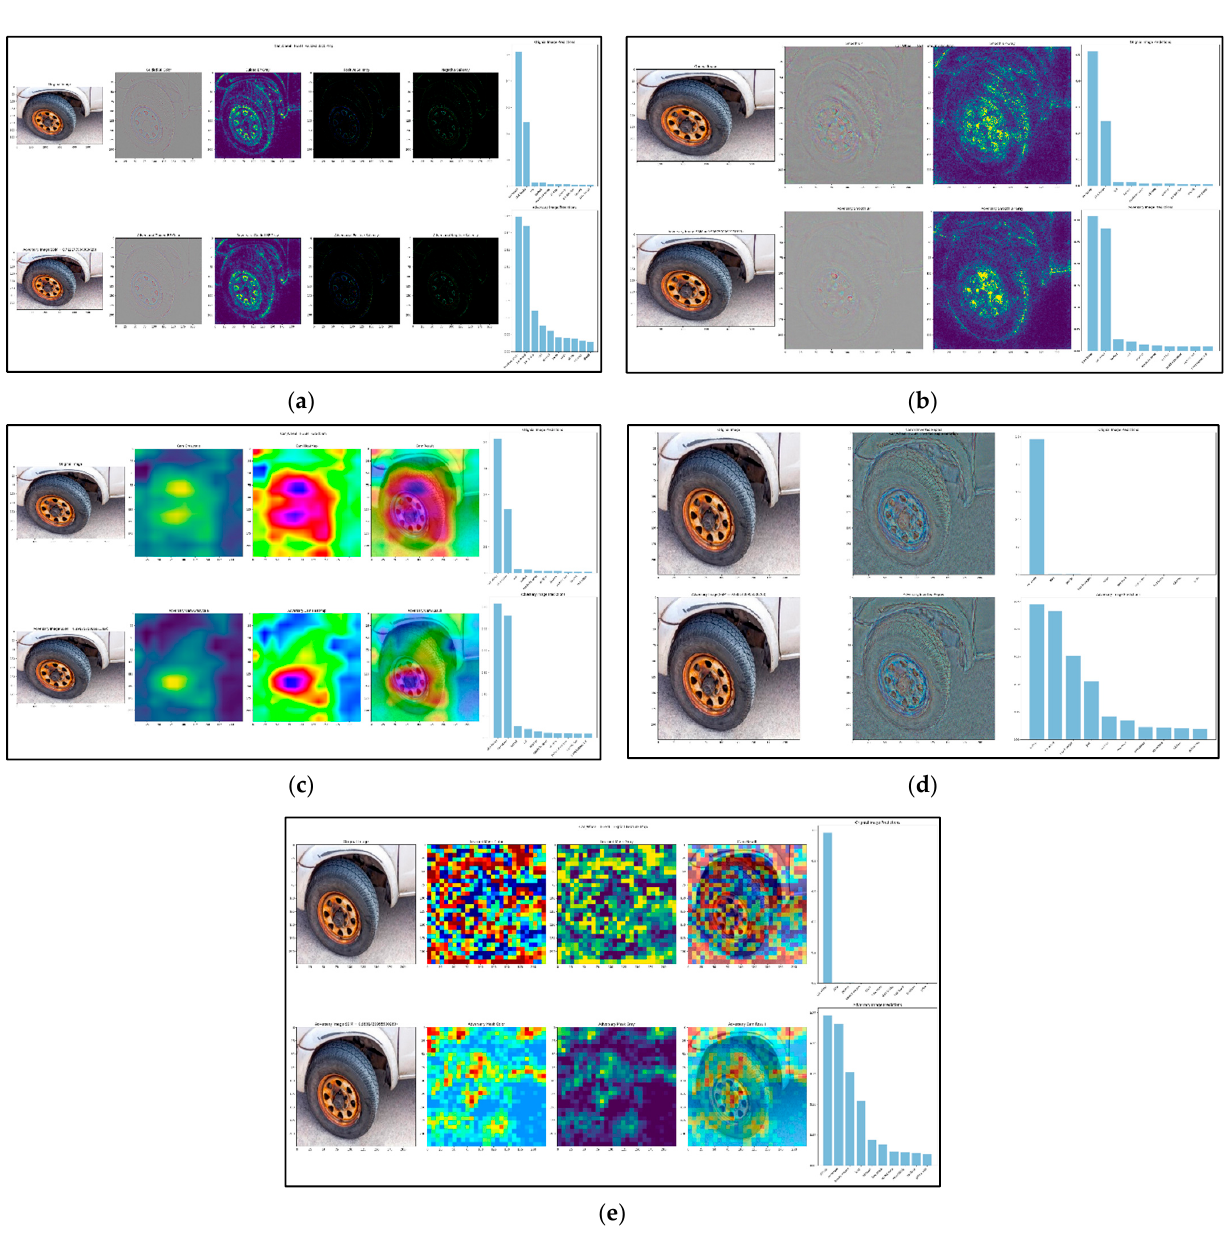
Figure 4. ( a ) Guided propagation model; ( b ) smooth grad; ( c ) guided class activated mapping; ( d ) inverted gradient; and ( e ) novel exploit feature-map.